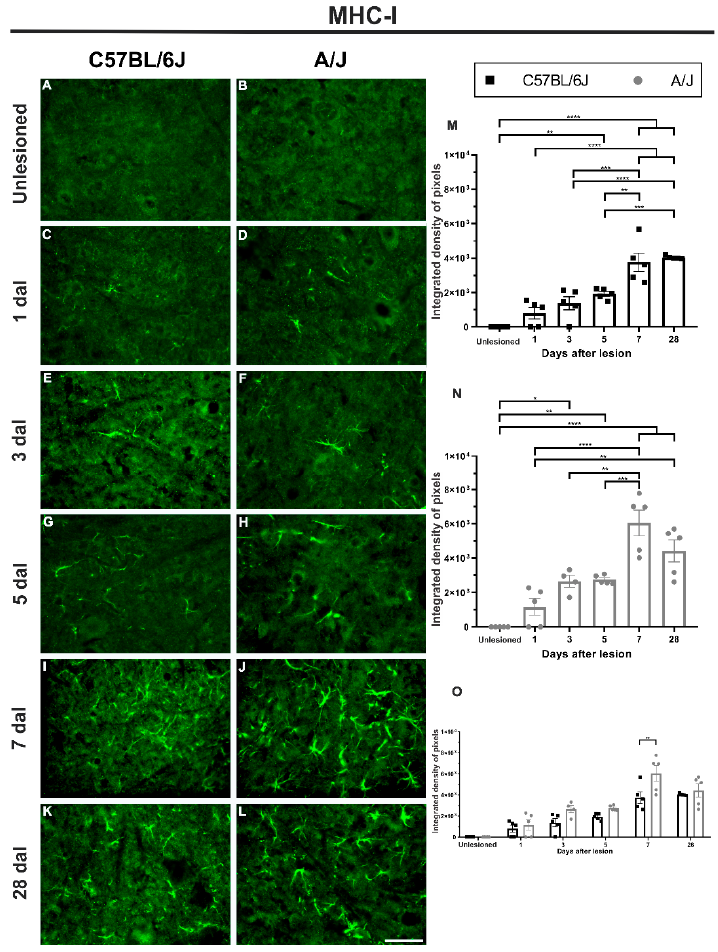
Figure 2. Immunostaining for MHC-I increases for both C57BL/6J and A/J strains after sciatic nerve crushing, with earlier and higher expression in the A/J strain when compared to C57BL/6J. ( A – L ) Representative images of lamina IX of Rexed from control animals (unlesioned) and in groups after peripheral nerve crush on Days 1, 3, 5, 7, and 28, ipsilateral to the lesion (with the exception of the control), in both strains. ( M ) MHC-I expression in C57BL/6J animals, showing its highest value within the first week, 7 days after lesion (dal), which remained upregulated at 28 dal. ( N ) MHC-I expression in A/J animals, with upregulated labeling at 3 dal, peaking at 7 dal, and remaining increased at 28 dal. ( O ) Comparison between the values found in the C57BL/6J and A/J strains on the different days after peripheral nerve injury, with a difference between the strains at 7 dal, being higher in the A/J mice. Quantification of the integrated density of pixels within lamina IX of Rexed (n = 5 per group/day; mean ± SEM; * p < 0.05; ** p < 0.01; *** p < 0.001; **** p < 0.0001). Scale bar: 50 µm.